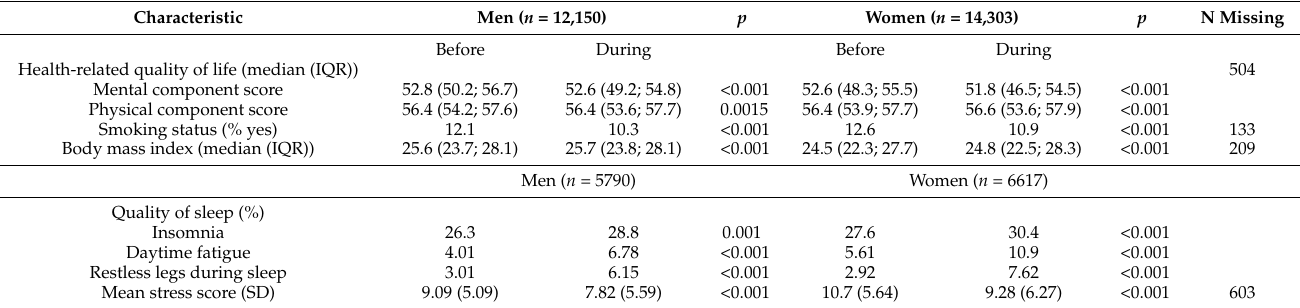
Table 2. Comparing population health characteristics before the COVID-19 pandemic with levels during the pandemic. Characteristic Men ( n = 12,150) p Women ( n = 14,303) p N Missing Before During Before During Health-related quality of life (median (IQR)) 504 Mental component score 52.8 (50.2; 56.7)